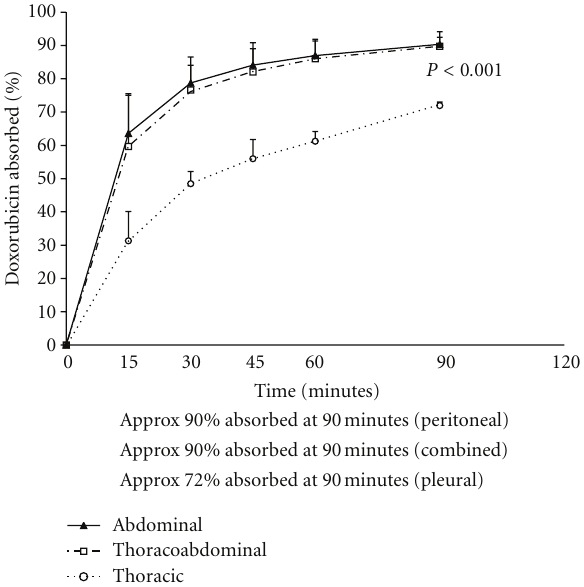
Figure 4: Comparison of percent of doxorubicin absorbed after 90 minutes of treatment from the abdominal cavity, thoracic and abdominal cavity, and the thoracic cavity